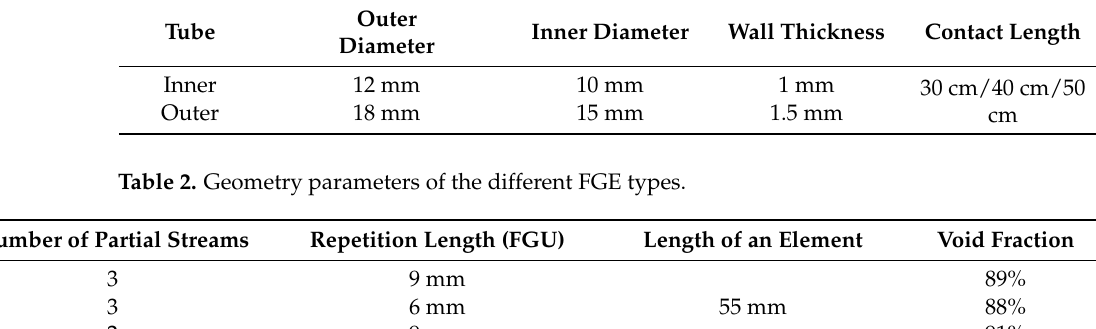
Table 1. Dimensions of the inlet and outlet pipes of the different reactors used in this study. HE-01 with 30 cm length, HE-02 with 40 cm length, and HE-03 with 50 cm length.